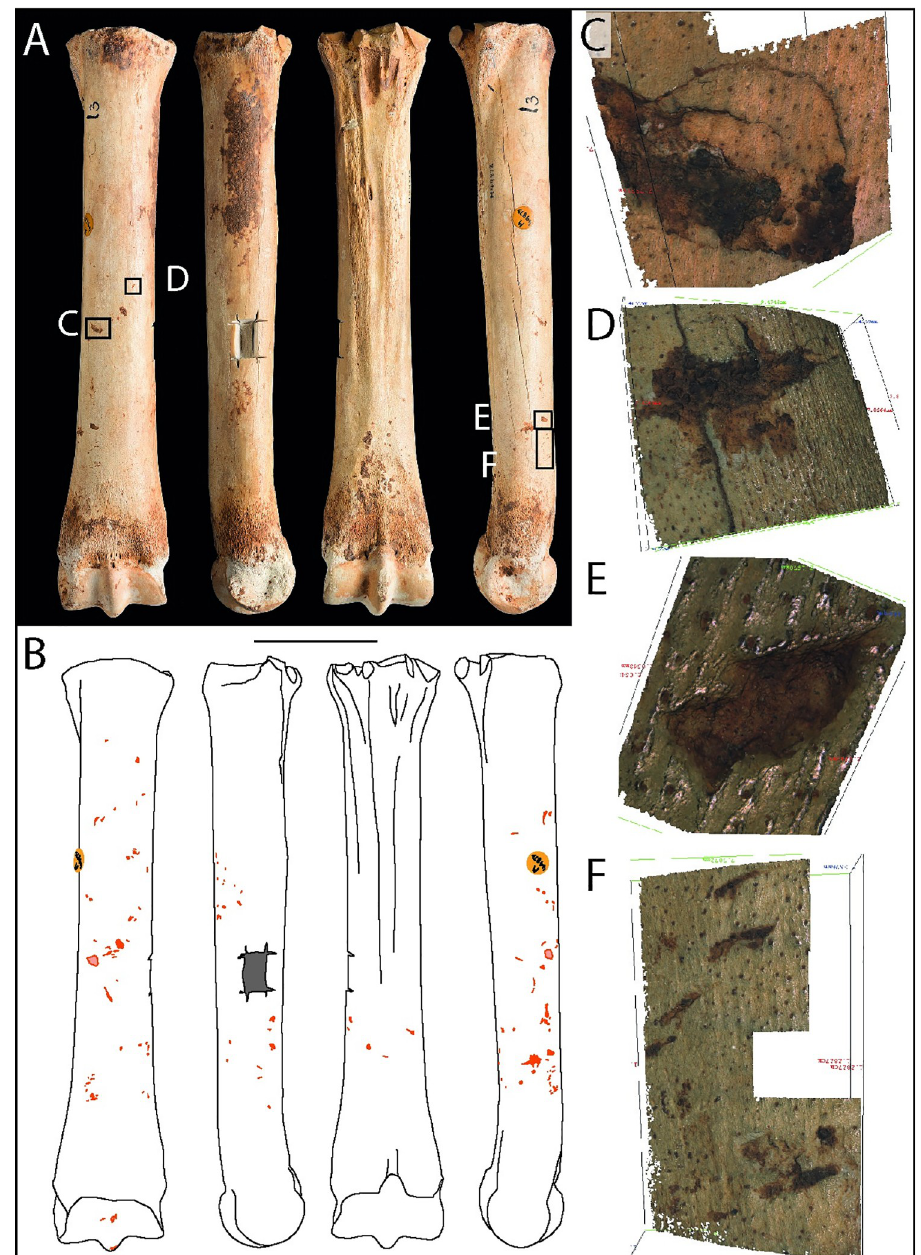
Fig 7. Photographs ( A ) and drawings ( B ) of horse metatarsal M49873, showing knapping marks (pink) and rectangular sample hole (dark grey) in dorsal, medial, plantar, and lateral views (Scale = 50 mm). Alicona images detailing wedge-shaped gouges ( C-E ) with concentric cracks demarcating depressed cortical bone ( C ), and shallower superficial scores ( F ). The identification of this specimen as a knapping tool is based on the recognition that not all of the pits were created by carnivore chewing. Hidden among the conspicuous traces of chewing is a second set of pit-like features on the dorsal surface. These are compression fea- tures and gouges, mostly located away from the main concentration of unambiguous carnivore